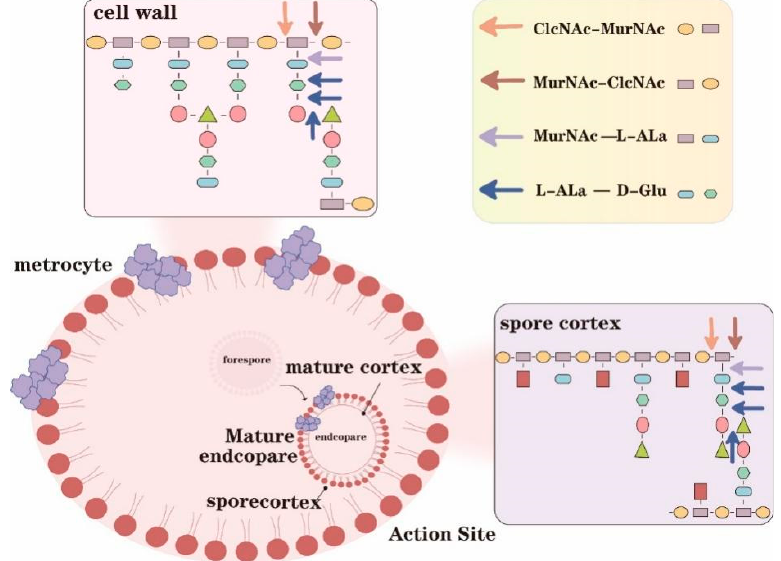
Figure 2. Mechanisms of autolysis in Bacillus subtilis site of action of autolysin. The peptidoglycan PG in the cell wall structure is the backbone component of the cell wall, and the side chains of the peptidoglycan are linked to anionic polymers, which provide the sites of action for autolysis en- zymes.